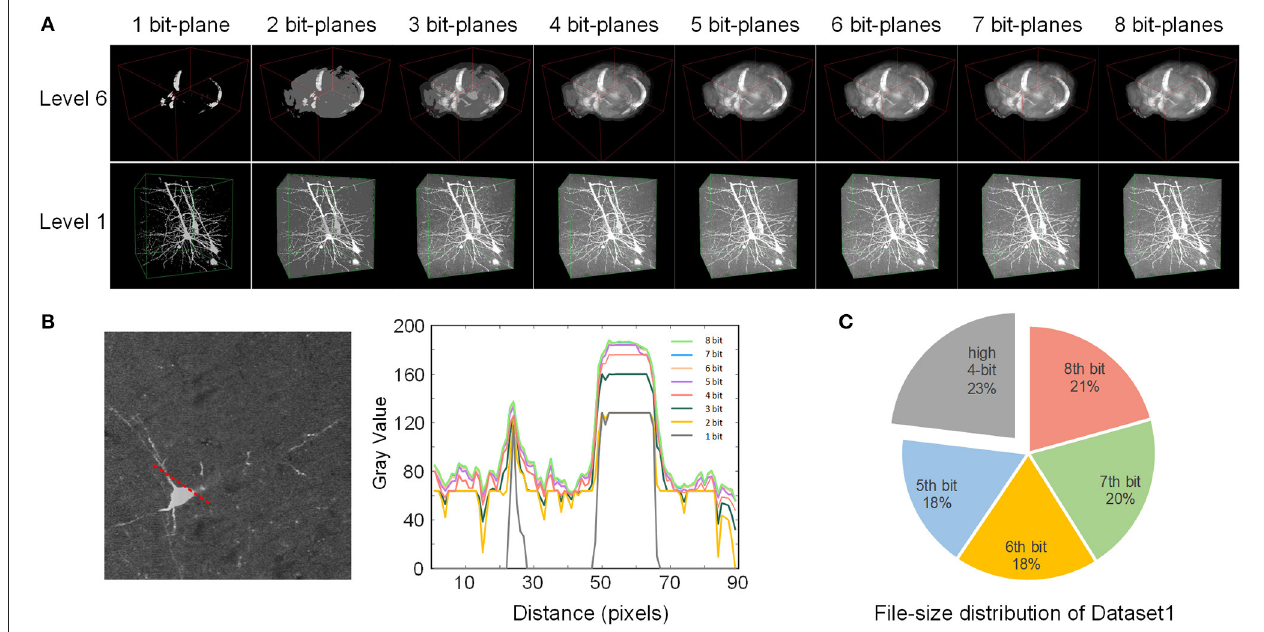
FIGURE 5 | Effect of the bit-plane-separated data format. (A) The rendering quality of two VOIs at different bit depths. The depth of the displayed VOIs increases gradually from left to right. (B) The intensity profile of the 2D slice along the red dotted line at different bit depths. The slice was selected from the level 1 VOI above. A plot profile of Fiji acquired the numerical value. (C) The file size of each bit-plane of Dataset1. The first four bit planes are shown together.